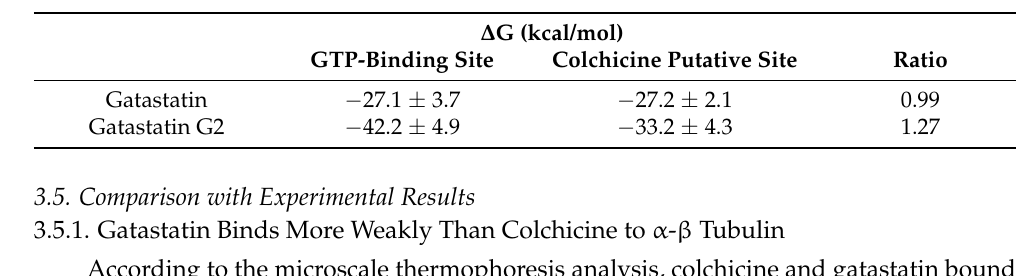
Table 7. Comparison of predicted binding affinities of gatastatin and gatastatin G2 in the GTP site and in the putative colchicine-binding site on γ tubulin.